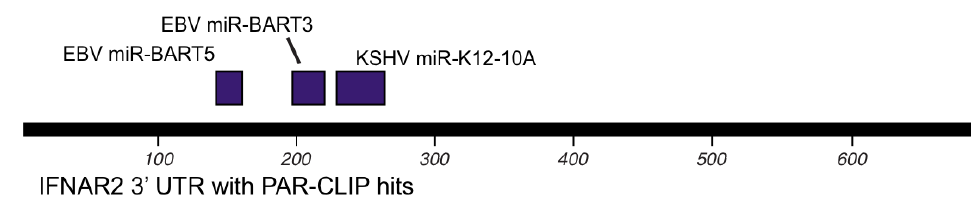
Figure 3. Map of interferon receptor 2 (IFNAR2) 3’UTR with miRNA target sites as determined by CLIP